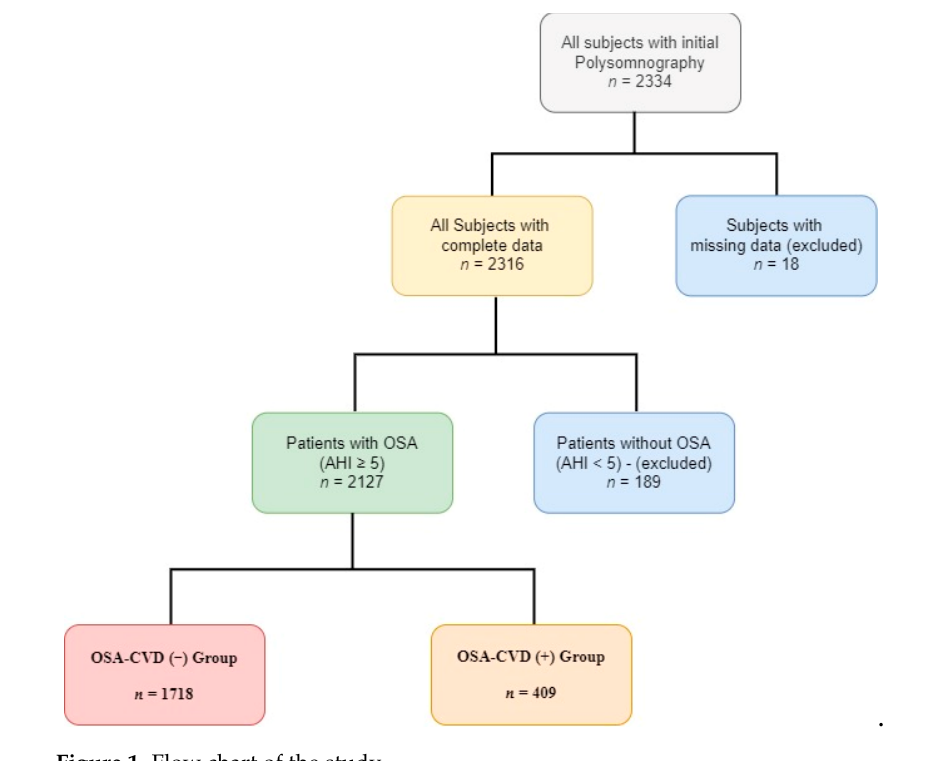
Figure 1. Flow chart of the study. Table 1. Characteristics of the study population.